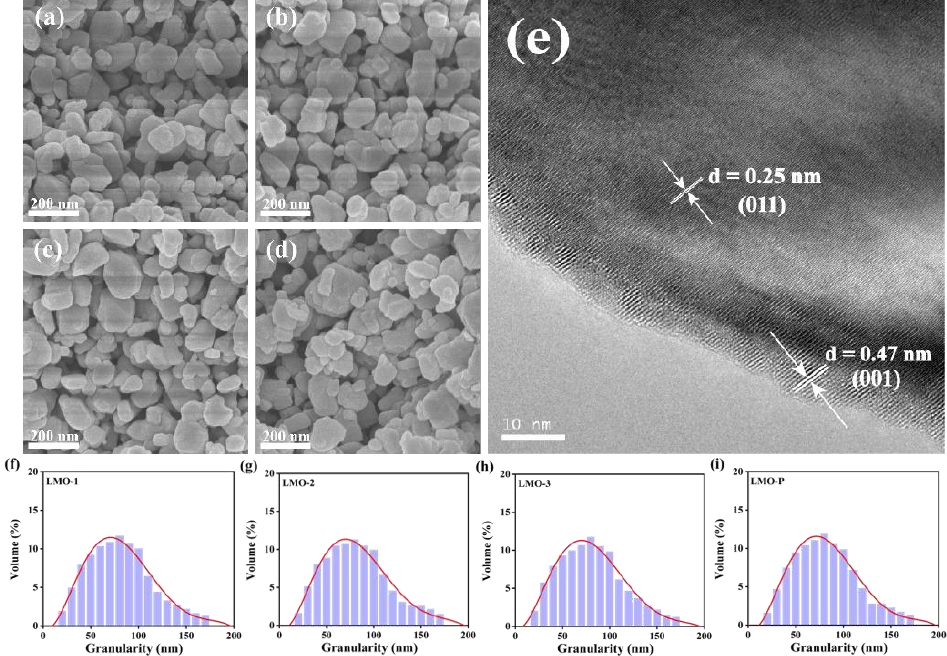
Figure 3. The SEM images of the various samples ( a – d ), TEM image of LMO-2 ( e ), and particle size distribution of the samples ( f – i ).